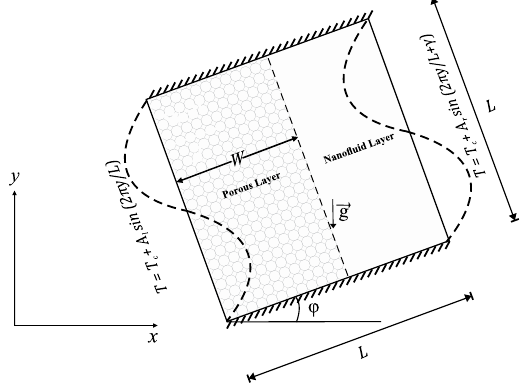
Figure 1. Physical model of free convection in an enclosure with the x and y coordinates and the inclination